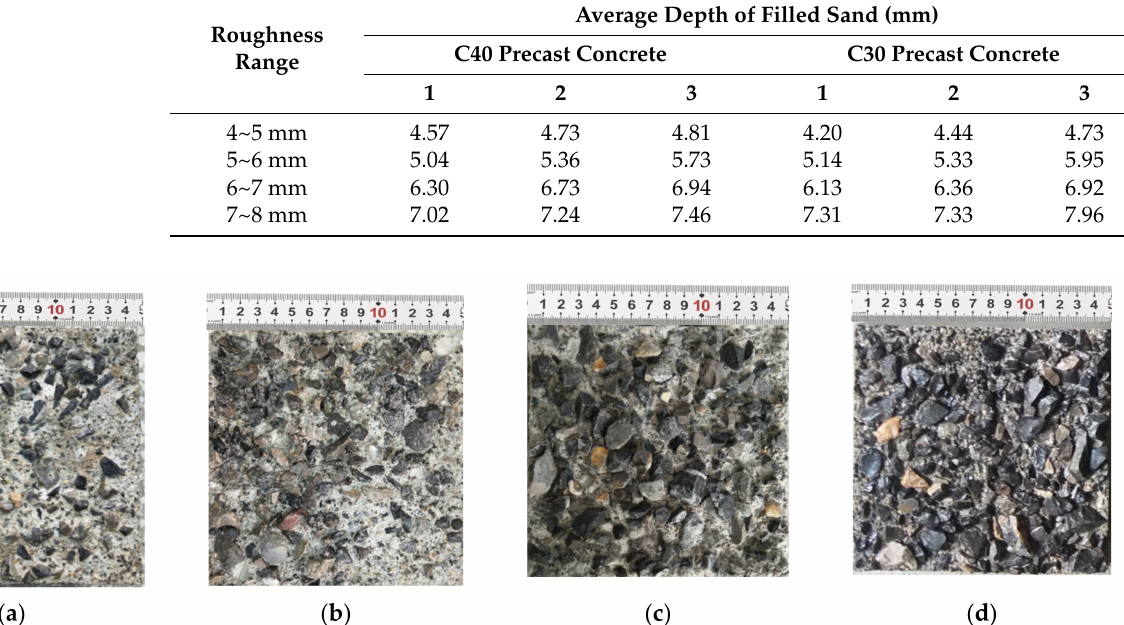
Figure 8. Washed rough surfaces of specimens in sectional dimension of 150 mm × 150 mm with different roughness: ( a ) 4~5 mm; ( b ) 5~6 mm; ( c ) 6~7 mm; ( d ) 7~8